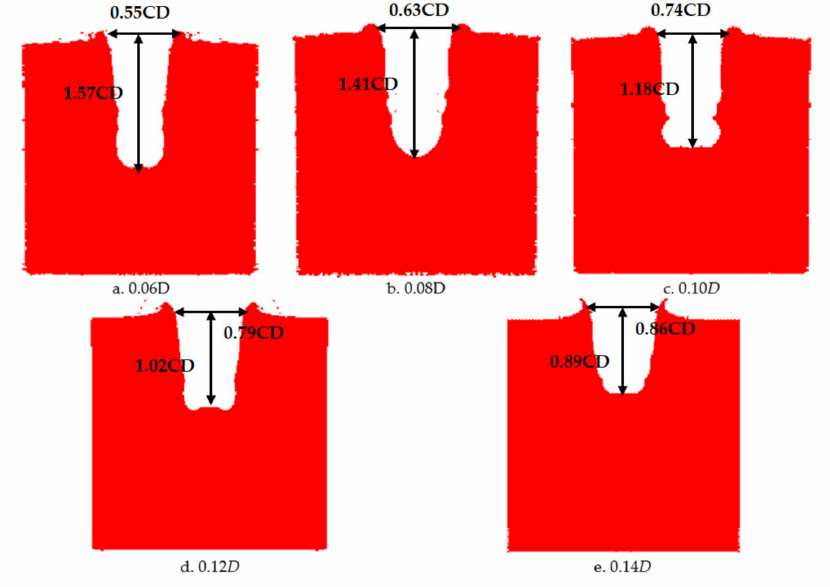
Figure 14. Damage effect of shaped charges with different wall thicknesses on a steel target. It can be seen from Figure 15 that the penetration depth of the reactive jet into the steel target decreases as the wall thickness of the reactive charge increases. From the perspective of energy conservation, under the same charge conditions the detonation energy of the main charge is constant, but when the wall thickness of the reactive charge differs, the mass differs as well and the velocity of the reactive jet in the driving process changes. The velocity of the reactive jet increases as the wall thickness of the reactive charge increases. However, with the increase in liner thickness, the average diameter of the reactive jet also increases, resulting in an increased diameter of the reactive